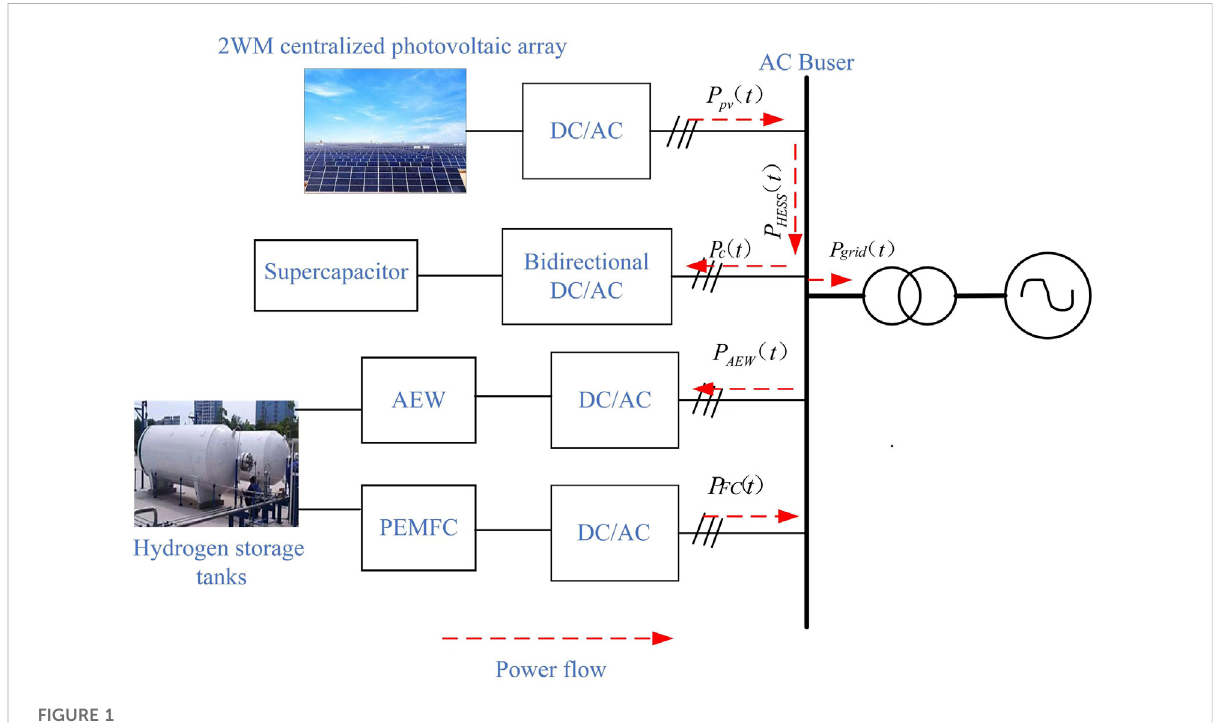
FIGURE 1 Topology of photovoltaic hydrogen hybrid energy storage